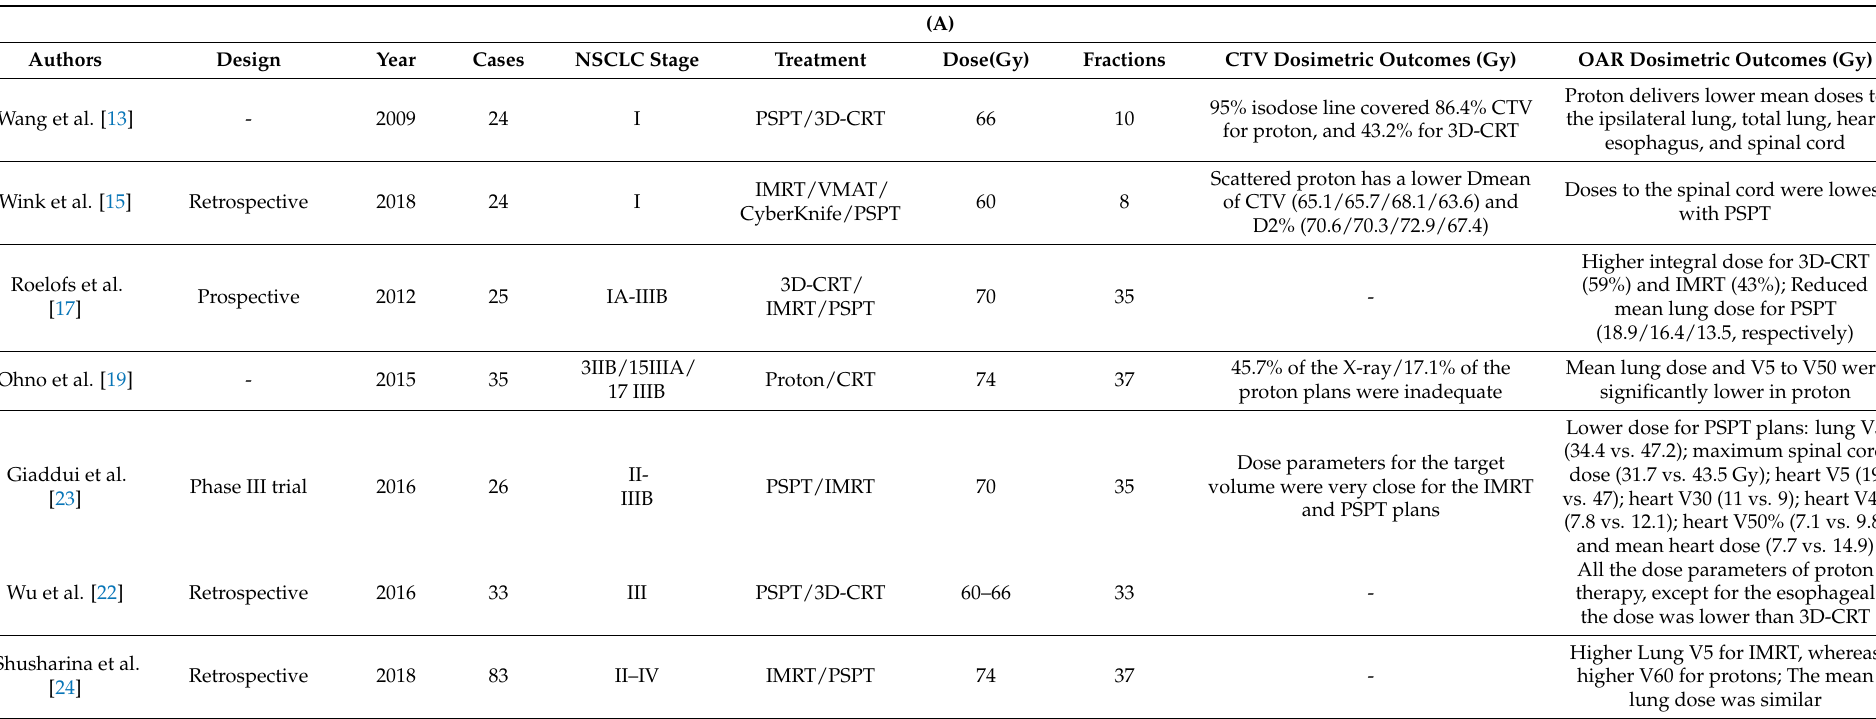
Table 1. ( A ). Published dosimetric comparative study involving proton therapy (PSPT) for NSCLC; ( B ) Published dosimetric comparative study involving proton therapy (IMPT) for NSCLC